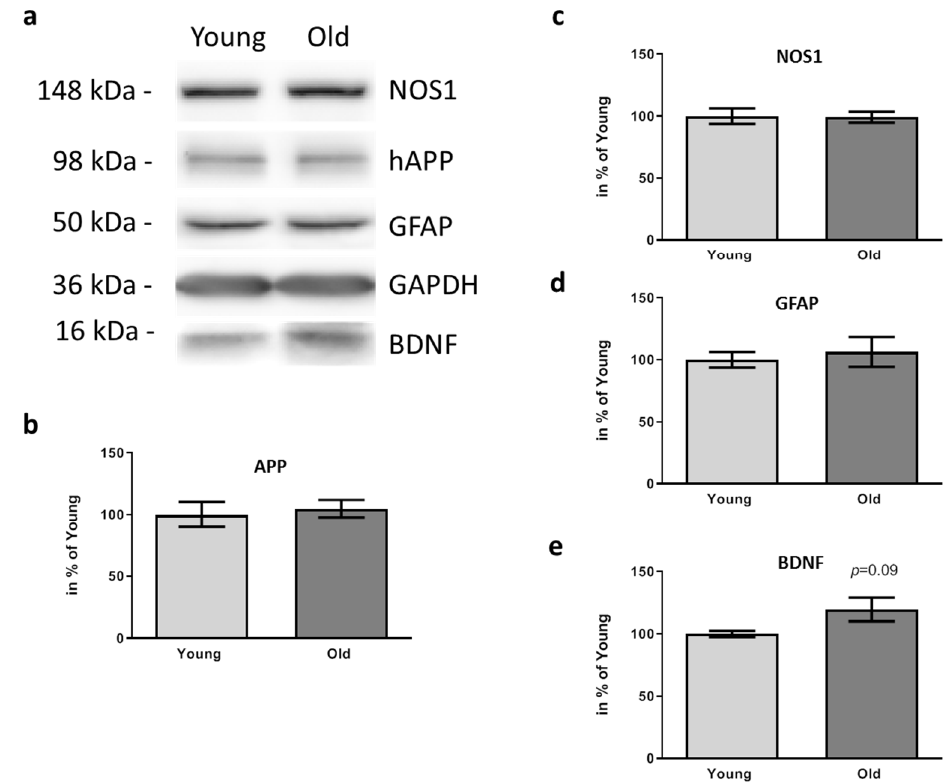
Figure 6. Effects of FMT donor age on inflammation and BDNF amount within PFC of 5xFAD mice. The PFC area of 5xFAD six weeks after treatment with cecal content form young or old wt mice was dissected and 17.5 µg of protein subjected to Western blotting after homogenization. Mice receiving material from young donors are designated “young”, those receiving material from old donors are designated as “old”. A representative sample pair for each of the detected proteins is shown ( a ). GAPDH served as a normalization control for all other detected signals. Quantitation ( b – e ) was performed based on sample sizes of n = 6–7 per group and values are presented as mean ± SEM in % of the mean of animals treated with caecum content from young donors (“Young”).